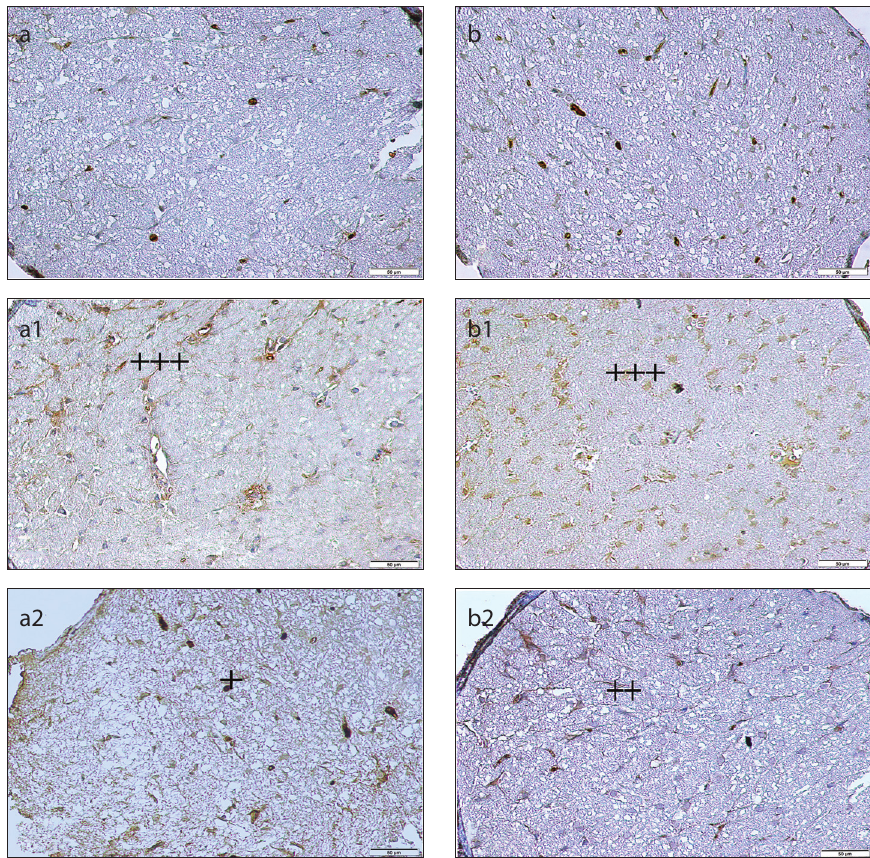
Figure 2. a-c. Electron photomicrographs of optic nerve tissues. (a) Myelinated axons in the sham group. (b) Separation of the myelin sheath (arrowhead), deterioration of axonal shape and demyelination areas (asterisks) in the AIR group. (c) Abnormal proliferation of connective tissue (curved arrow) between the normal myelinated axons (arrow) in the AIR10 group. Bars: 1 μm.